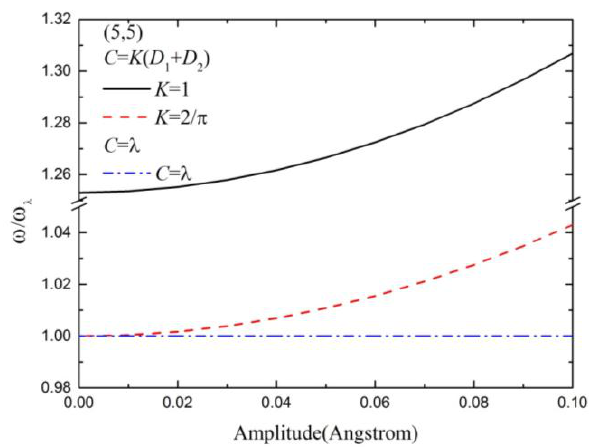
Figure 5. The normalized vibration frequency distribution with different amplitudes by using three modified coefficients of vdW interactions for a carbon chain inside (5,5) CNT.